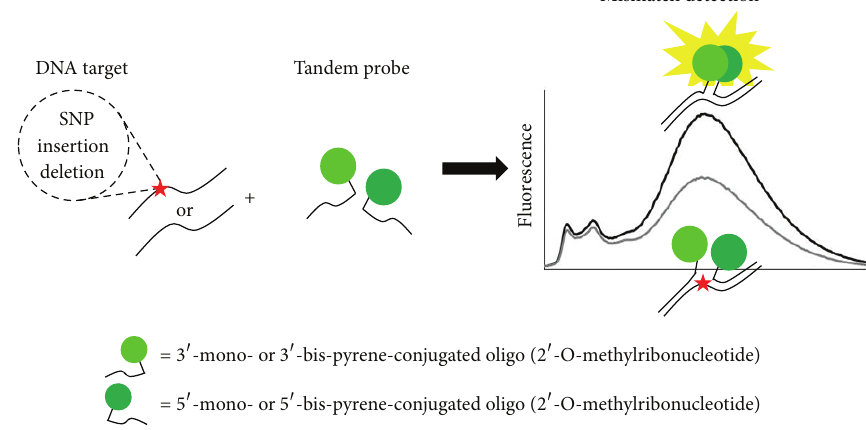
Figure 1: The scheme of the proposed concept of multipyrene tandem probes